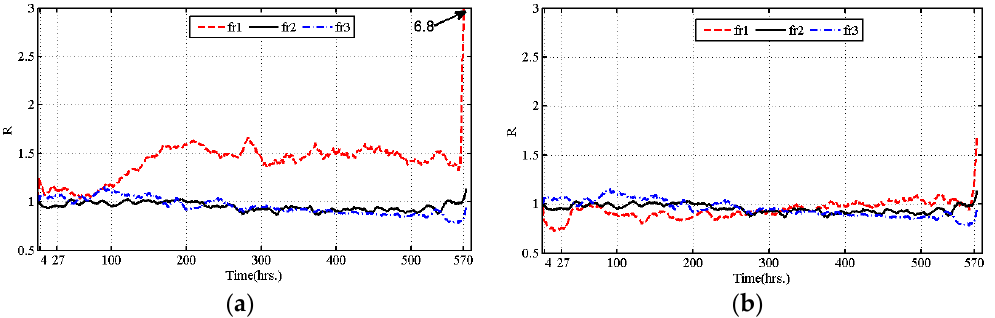
Figure 4. The monitoring trends of R. ( a ) trend of R ( f rx , f m 1 , i ); ( b ) trend of R ( f rx , f m 2 , i ).